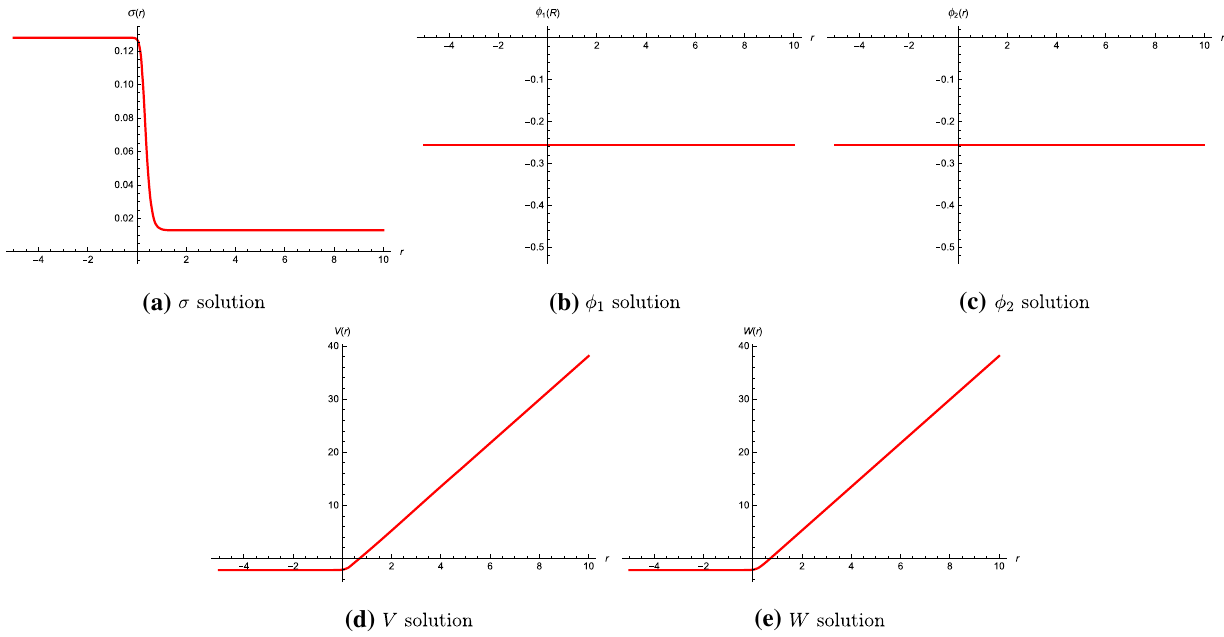
Fig. 7 An RG flow from SO ( 3 ) N = ( 1 , 0 ) SCFT in six dimensions to two-dimensional N = ( 2 , 0 ) SCFT with SO ( 2 ) diag symmetry dual